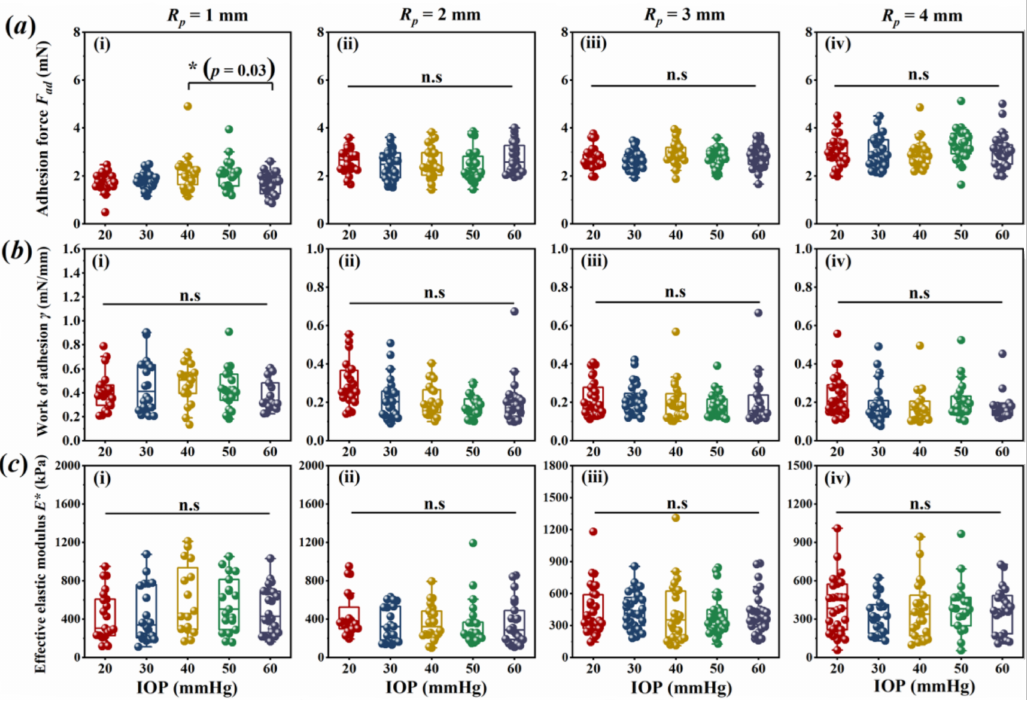
Figure 2. Parameters obtained from the experiment: ( a ) adhesion force ( F ad ); ( b ) work of adhesion γ ; ( c ) effective elastic modulus E*. ( n.s indicates no statistical differences among the different groups, with p > 0.05 and * p <